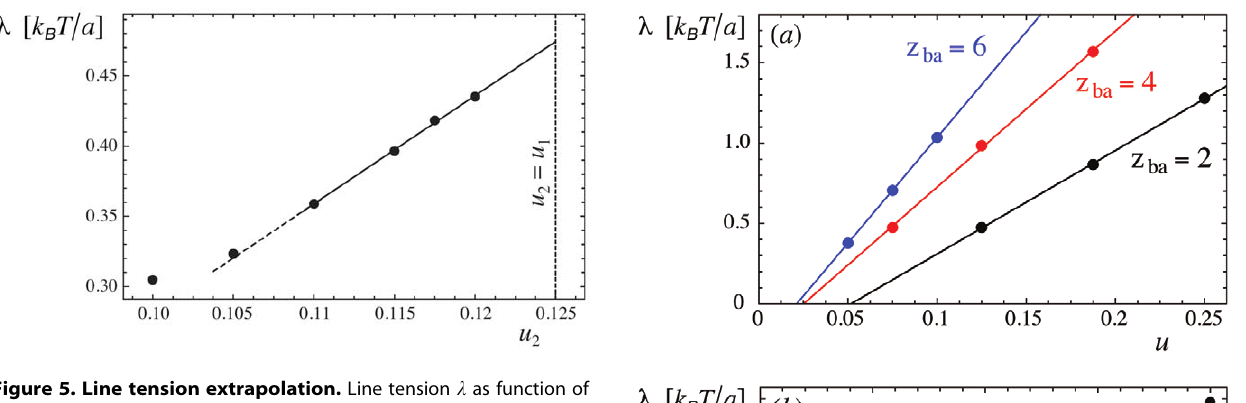
Figure 5. Line tension extrapolation. Line tension l as function of the rescaled depth u 2 of well 2 for the rescaled depth u 1 ~ 0 : 125 of well 1. The six data points result from the six values of the critical radius r c determined in fig. 4. The line tension l is obtained from the critical radii as l ~{ r c D f b (see eq. (22)), with the free energy difference D f b calculated from eq. (18) with the function P b ( u ) ^ P (3) ( u ) given in b Appendix S2 and in the caption of fig. 2. Linear extrapolation of the four right data points leads to the estimated value l ~ 0 : 474 + 0 : 002 k B T = a